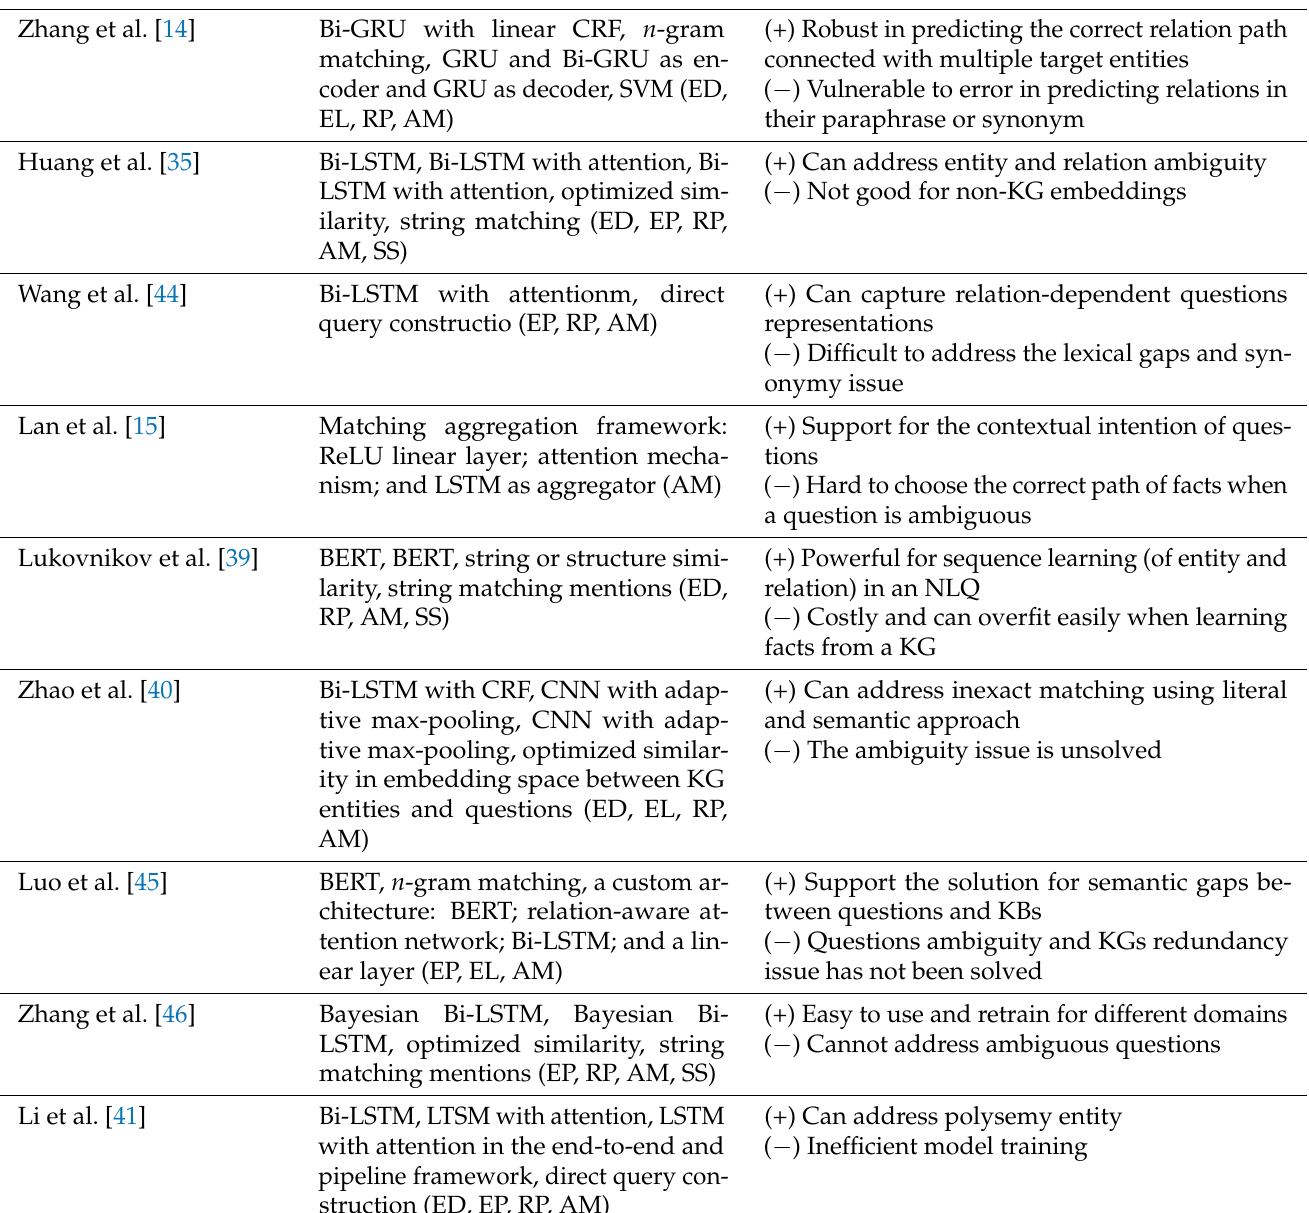
Table 5. KGSQA systems proposed from 2019 to 2021 and its strengths and